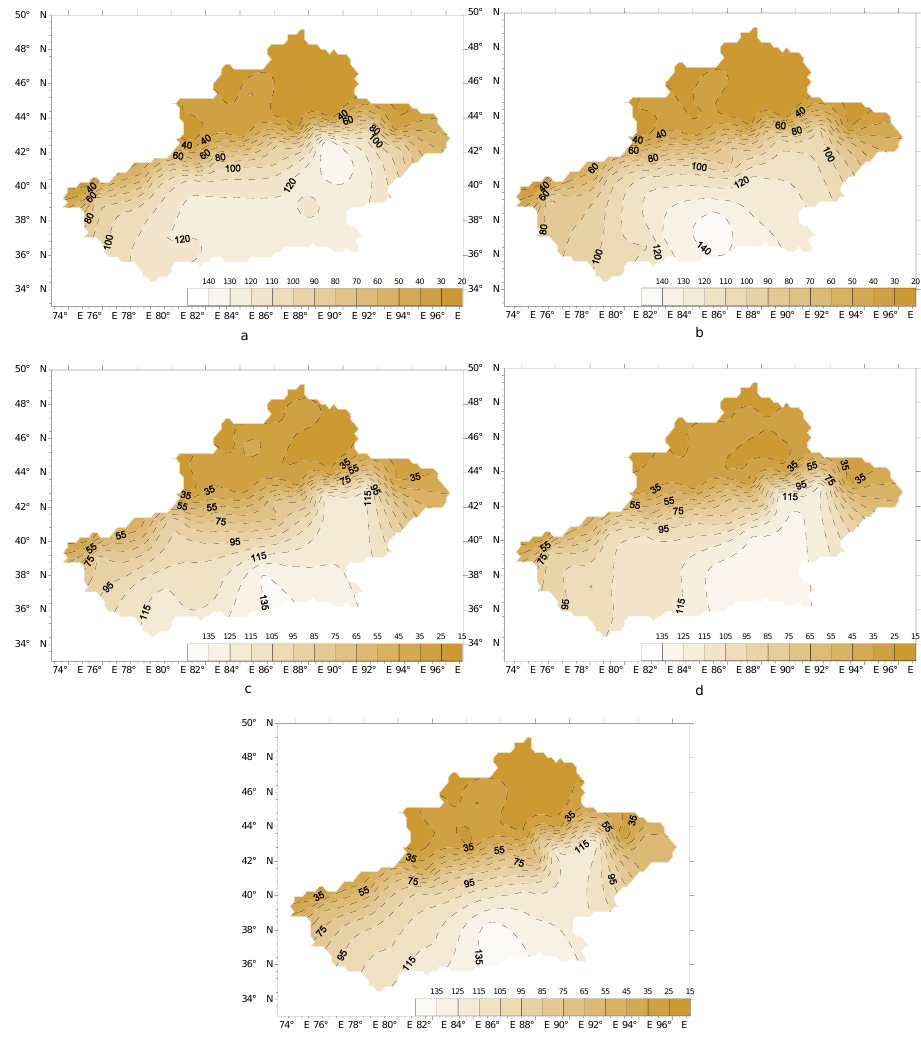
Figure 6 Fig. 6. Spatial distribution of decadal average CDD in Xinjiang: (a) 1961–1970; (b) 1971–1980; (c) 1981–1990; (d) 1991–2000; (e) 2000–2008. Table 2. Return level estimates for T=10, 20, 50, 100 over all Xinjiang. Return level (95% confidence interval) GEV distribution